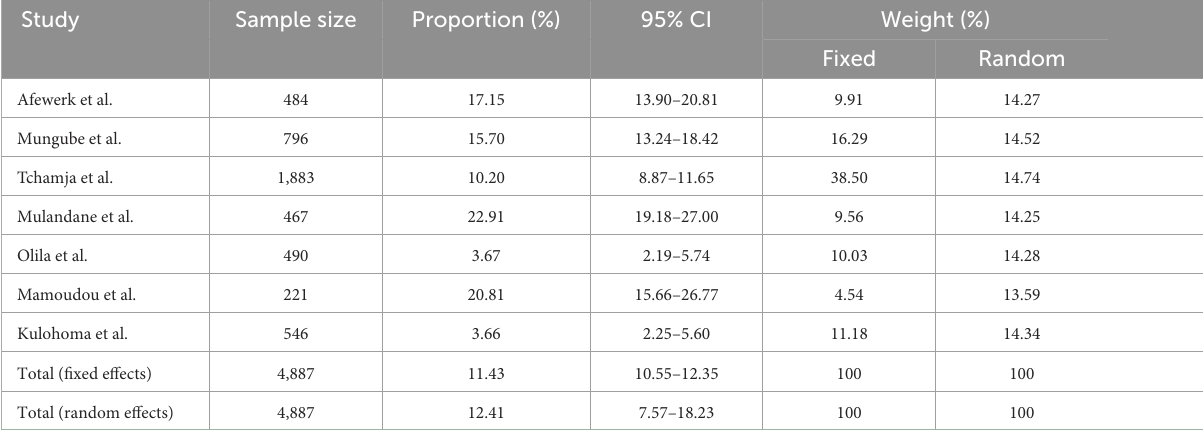
TABLE 3 Meta-analysis on the prevalence of African animal trypanocide